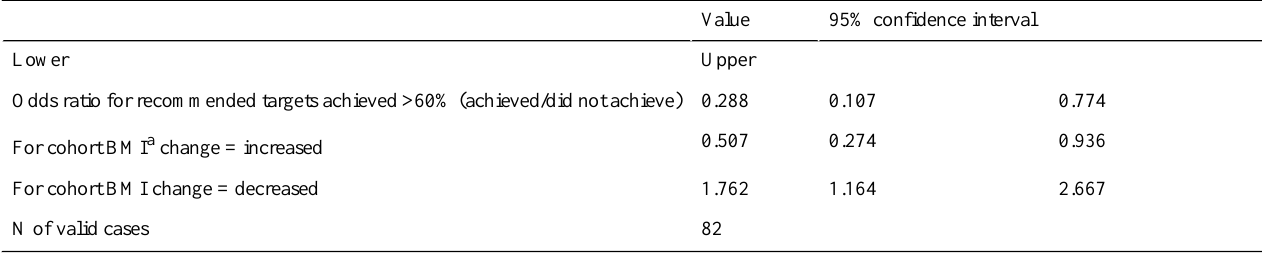
Table 3. Odds ratio and relative risk analysis for participants who achieved more than 60% of their recommended daily targets (mean) and body mass index change